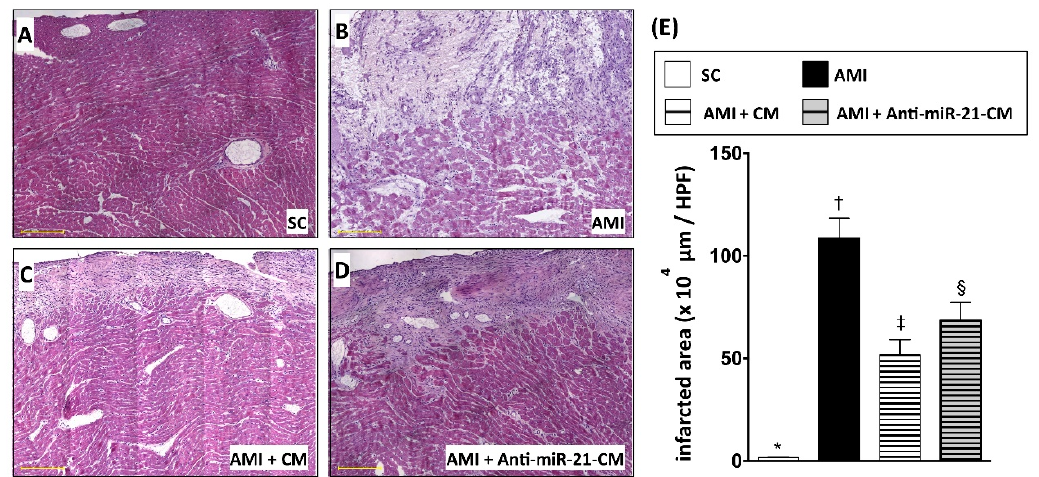
Figure 6. Inhibition of miR-21 reduced the effect of conditioned medium on ameliorating myocardial infarction. ( A ) Histopathological examination on sham-control myocardial section with hematoxylin and eosin (H&E) staining. ( B ) H&E staining for myocardial section from rats with AMI induction. ( C ) H&E staining for myocardial section from rats with AMI induction and injection of conditioned medium OGD-treated cardiomyocytes. ( D ) H&E staining for myocardial section from rats with AMI induction and injection of conditioned medium derived from OGD-treated cardiomyocytes with anti-miR-21 pre-transfection. ( E ) Calculation of infarcted area in myocardium. SC, sham control. AMI, acute myocardial infarction. CM, conditioned medium derived from OGD-treated cardiomyocytes. Anti-miR-21-CM, conditioned medium derived from cardiomyocytes pre-transfected with Anti-miR-21 (20 nM). Groups with di ff erent symbols (*, †, ‡, §), p < 0.05. n = 8 for each group. Scale bar in left lower corner indicated 200 μ m.